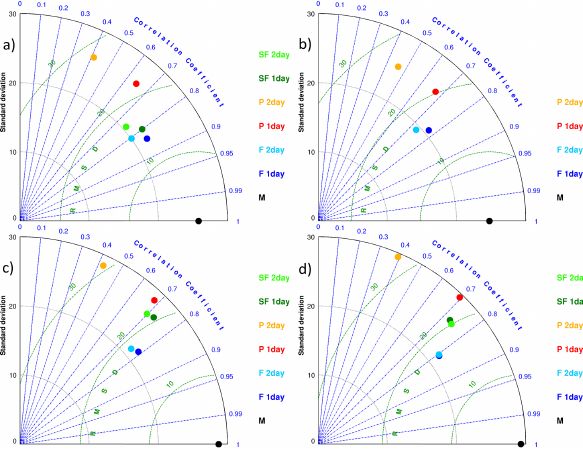
Figure 9. Taylor diagrams comparing 1-day and 2-day ozone daily maximum statistical forecast (SF), persistence (P) and WRF-Chem forecast (F) for (a) subalpine urban stations with SF (LJ, HRA), (b) subalpine urban stations without SF (CE, TRB, ZAG, VEL), (c) rural stations with SF (MS, ISK, KRV, OTL) and (d) Mediter- ranean urban stations (NG,